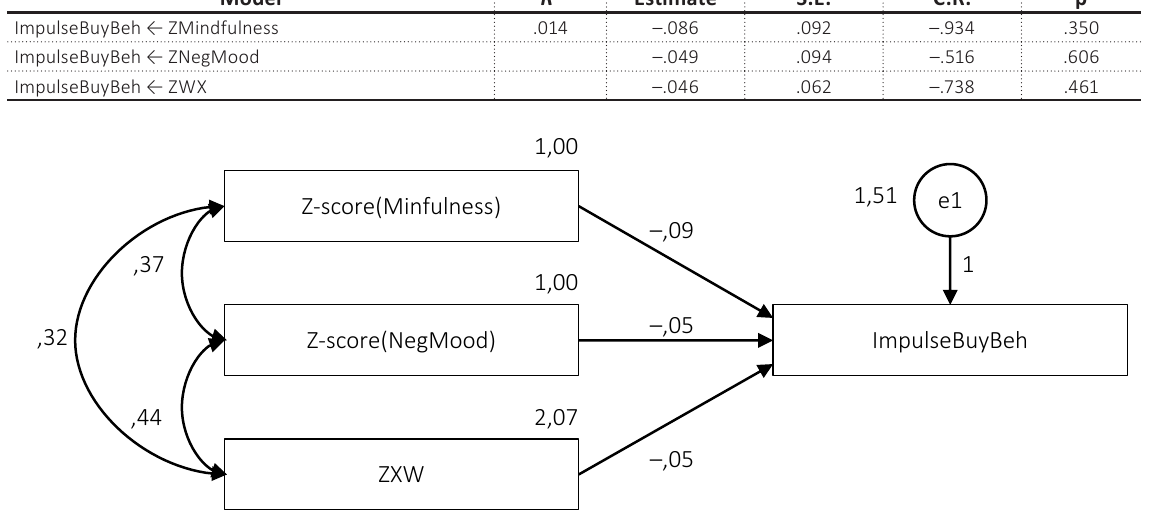
Figure 6. The standardized path diagram of the moderator effect of negative mood on the relationship between mindfulness and impulse buying behavior